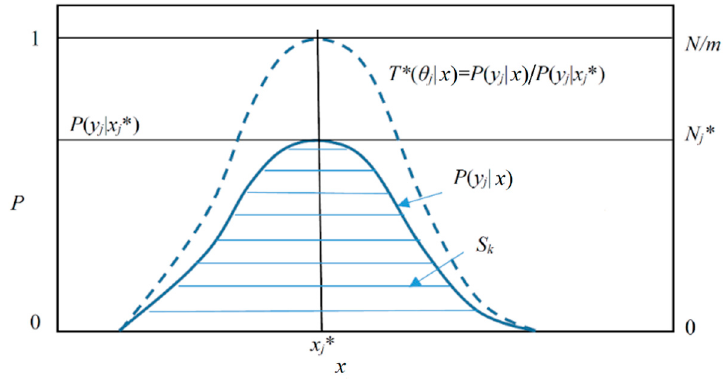
Figure 3. The optimized truth function (dashed line) is the same as the membership function obtained from the statistics of a random set [37]. S k is a set-value (a thin line); N j is the number of set-values.